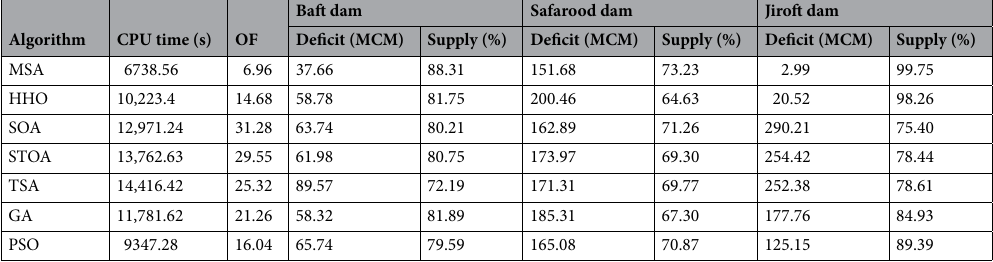
Table 2. Objective function and deficit of reservoir demands resulting from the run of algorithms.